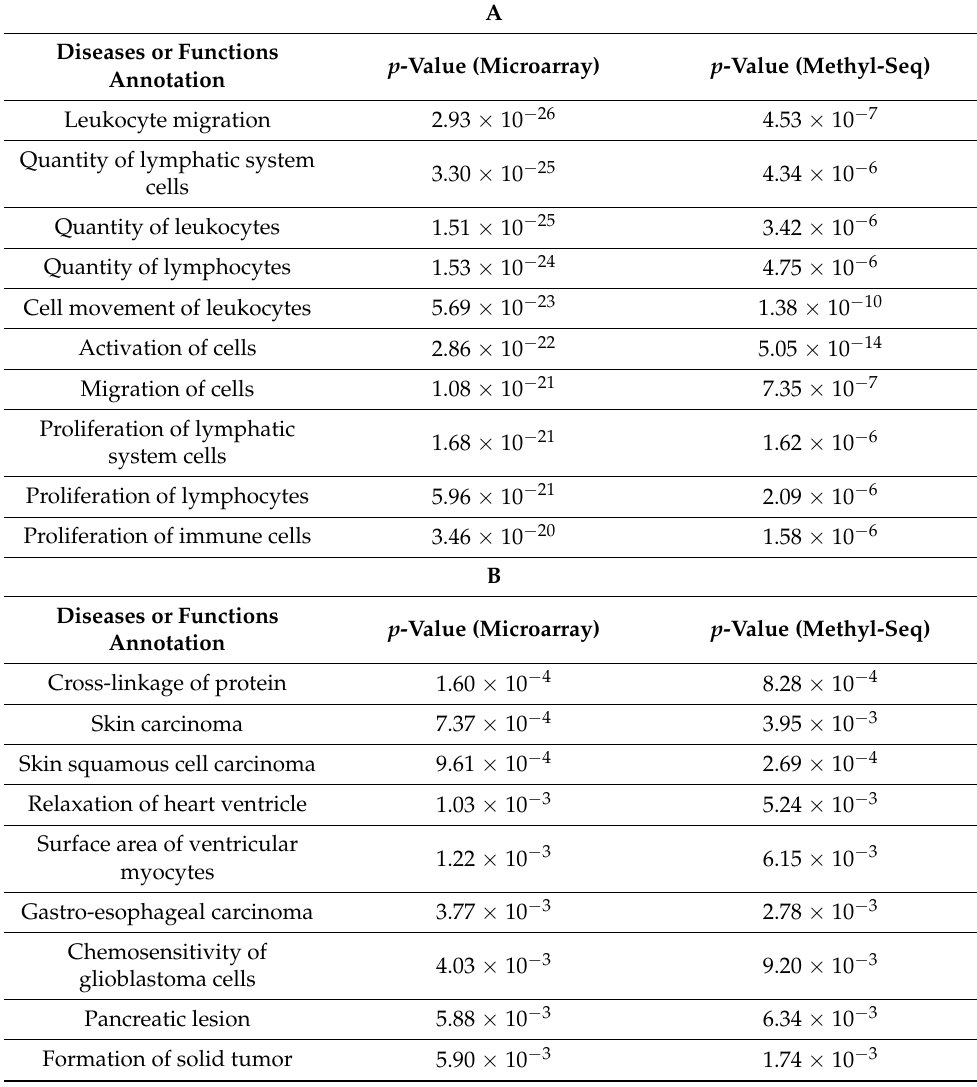
( A ) Top 10 functions identified from gene promoters methylated in placenta but not in cord blood. ( B ) Functions identified from gene promoters methylated in cord blood but not in placenta. (Only 9 common annotations were